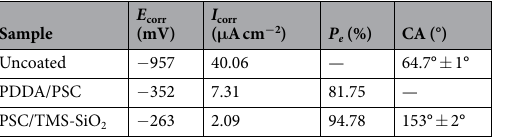
with nano-porous structure (supported by Fig. 5), which impedes the penetration of water and aggressive species to approach the SS surface. Electrochemical impedance spectroscopy (EIS) was used as an alternative method to evaluate the corrosion protection ability of the coatings. Fig. 7b shows the Nyquist plot and Fig. 7c,d shows the Bode plot of the PDDA/ PSC, PSC/TMS-SiO 2 coating and uncoated 316SS in 3.5% NaCl solution. The Nyquist plot of the coated sam- ples, exhibits a high impedance with single capacitive loop than the uncoated ones. The corrosion resistance of different samples can be quantified by fitting the EIS data using equivalent circuits which provide the selective information about the permeability of the corrosive species involved in coating degradation 62 . The equivalent circuits used for uncoated and coated samples are shown in Fig. 7b1 and b2. These equivalent circuits consist of charge transfer resistance ( R ct ) and solution resistance ( R s ) with double layer capacitance ( C dl ) 63 . For coated samples, the equivalent circuit added with the coating capacitance C c and resistance R c . The double layer behavior was expressed as constant phase element ( CPE ) in the electrical equivalent circuit and used when a deviation was observed from the pure-capacitive behavior to obtain a better simulation and it is expressed in the following equation as 64 :